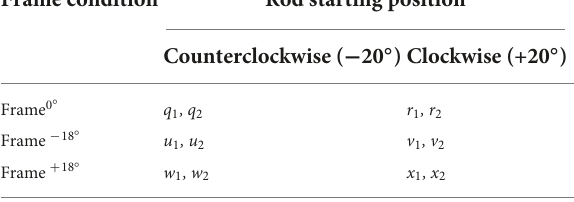
TABLE 2 The six different combinations of rod and frame conditions. Frame